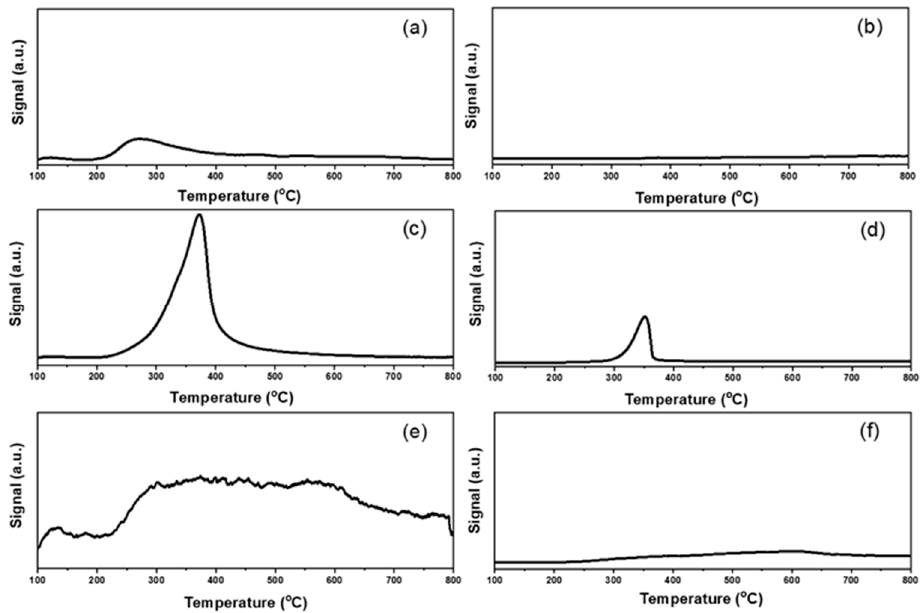
Figure 6. CO 2 -temperature programmed desorption profiles of di ff erent supported gold catalysts: Figure 6. CO 2 - temperature programmed desorption profiles of different supported gold catalysts: ( a ) Au 25 / ZnAl-300; ( b ) Au 25 / ZnO-300; ( c ) Au 25 / MgAl-300; ( d ) Au 25 / MgO-300; ( e ) Au 25 / Al 2 O 3 -300; ( a ) Au 25 /ZnAl-300; ( b ) Au 25 /ZnO-300; ( c ) Au 25 /MgAl-300; ( d ) Au 25 /MgO-300; ( e ) Au 25 /Al 2 O 3 -300; ( f ) Catalysts 2020 , 10 , x FOR PEER REVIEW 10 of 20 ( f ) Au 25 / SiO 2 -300. Au 25 /SiO 2 -300.